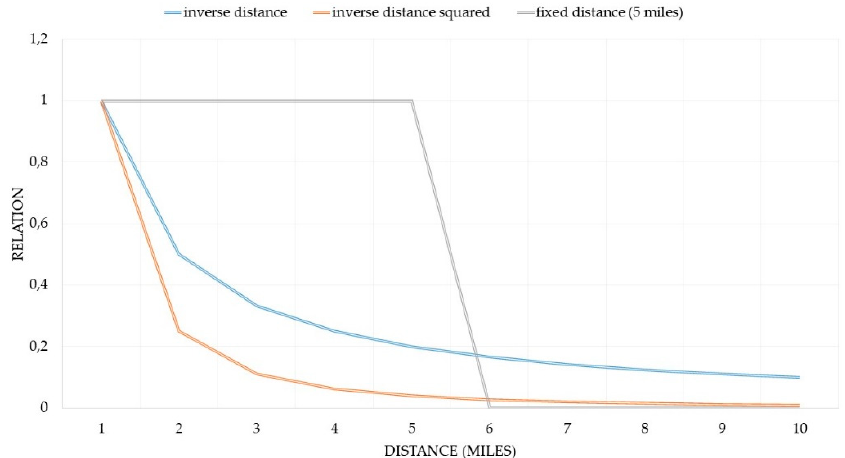
Figure 2. Relationships between entities according to the different types of spatial relationships.